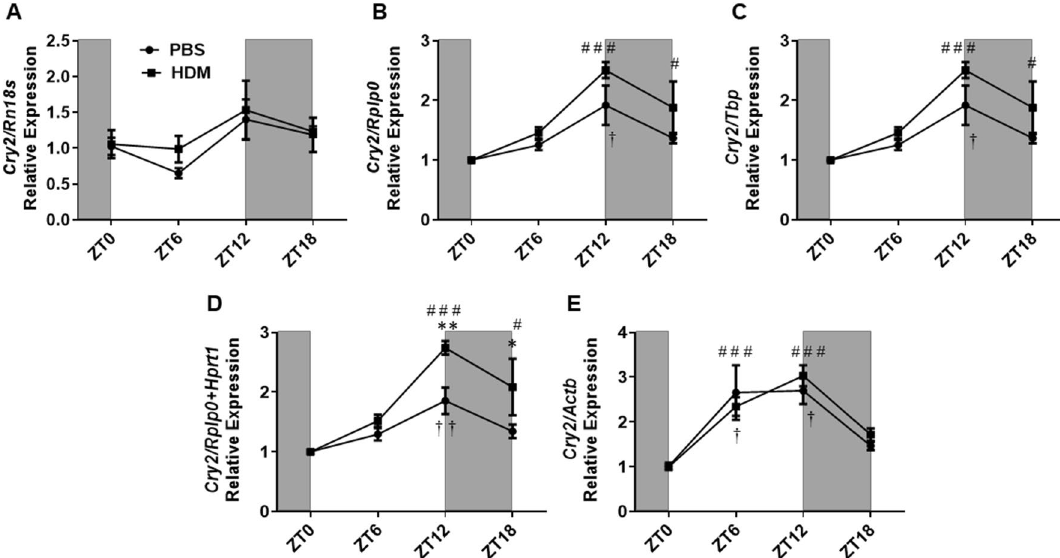
Figure 8. Cry2 gene relative expression in HDM and PBS exposed mouse lungs and data normalized with different reference genes. ( A ) Rn18s , ( B ) Rplp0 , ( C ) Tbp , ( D ) Rplp0/Hprt1 and ( E ) Actb . Line graphs showing the relative expression of Cry2 gene in both HDM versus PBS group. White and gray areas in the graph represents the light and dark cycle, respectively. Symbols † and # represent the statistical significance in temporal expression of Cry2 in the PBS and HDM group respectively at the marked time point when compared to the baseline (ZT0). Data are shown as mean ± SEM (n = 4/group; * P < 0.05, ** P < 0.01 compared to respective control; † P < 0.05, †† P < 0.01, compared to ZT0 PBS; # P < 0.05, # # # P < 0.001, compared to ZT0